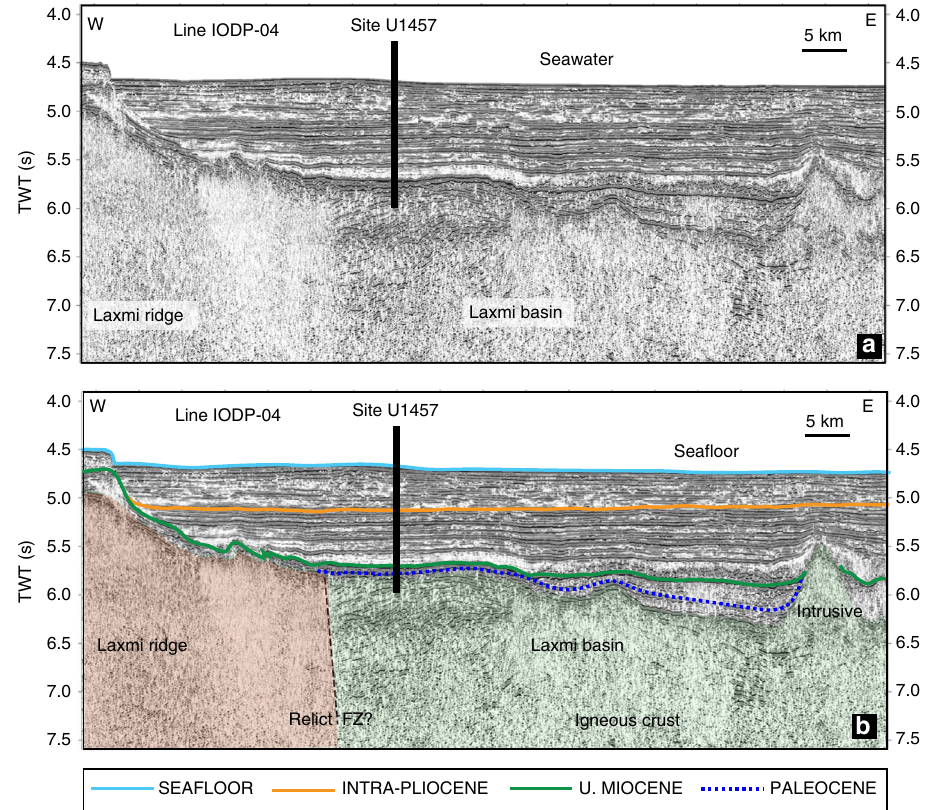
Fig. 2 Seismic structure beneath the Laxmi basin. Location of IODP drill Site U1457 along the regional seismic pro fi le IODP-04. The uninterpreted ( a ) and interpreted ( b ) sections are presented. Site U1457 26 is strategically located between the Laxmi ridge and Laxmi basin. The igneous basement in Laxmi basin was reached at ~1090 m below sea fl oor (mbsf). Overlying Cenozoic sedimentary horizons are marked on the interpreted section. TWT (s) — two-way travel time. A 30 m thick early Paleocene 26 unit (~63 Ma) overlies the igneous basement. Additional crustal age constraints are gathered from published magnetic anomalies 18 . Laterally coloured igneous basement section represents crustal segments corresponding to asymmetrically thick crusts on either sides, having different af fi nity and ages 18 . Based on seismic re fl ection characters and available magnetic age constraints, we propose a potential weak zone (FZ), which may have been responsible for inferred transient